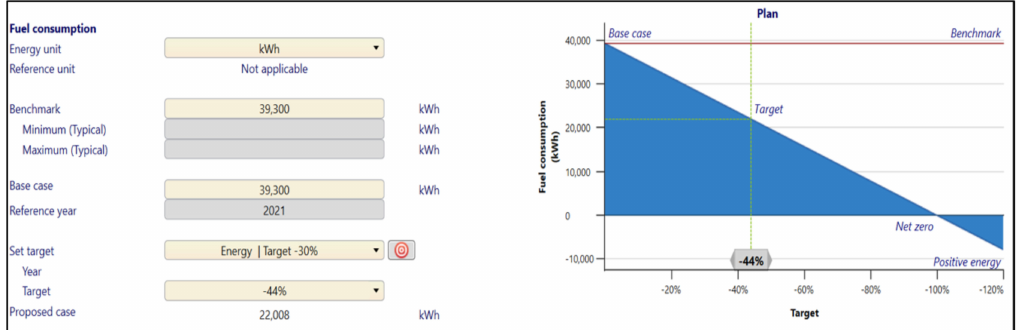
Figure 9. Photovoltaic system design target, 44% reduction in grid energy consumption, obtained from Retscreen expert V.8. Case proposal 22,008 kWh.